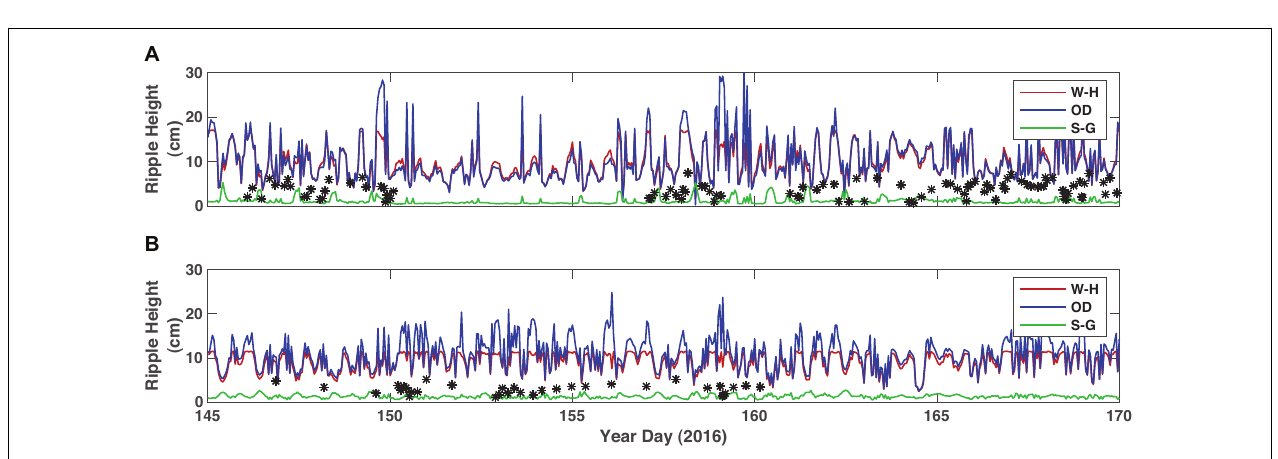
FIGURE 11 | Comparison of measured and modeled equilibrium bedform dimensions. (A) TR2 on the inner reef flat. (B) TR3 in the lagoon. Color represents the equilibrium bedform model: Red = Wiberg and Harris, 1994, green = Styles and Glenn (2002), and blue = O’Donoghue et al. (2006). Black stars denote ripple amplitudes as measured by